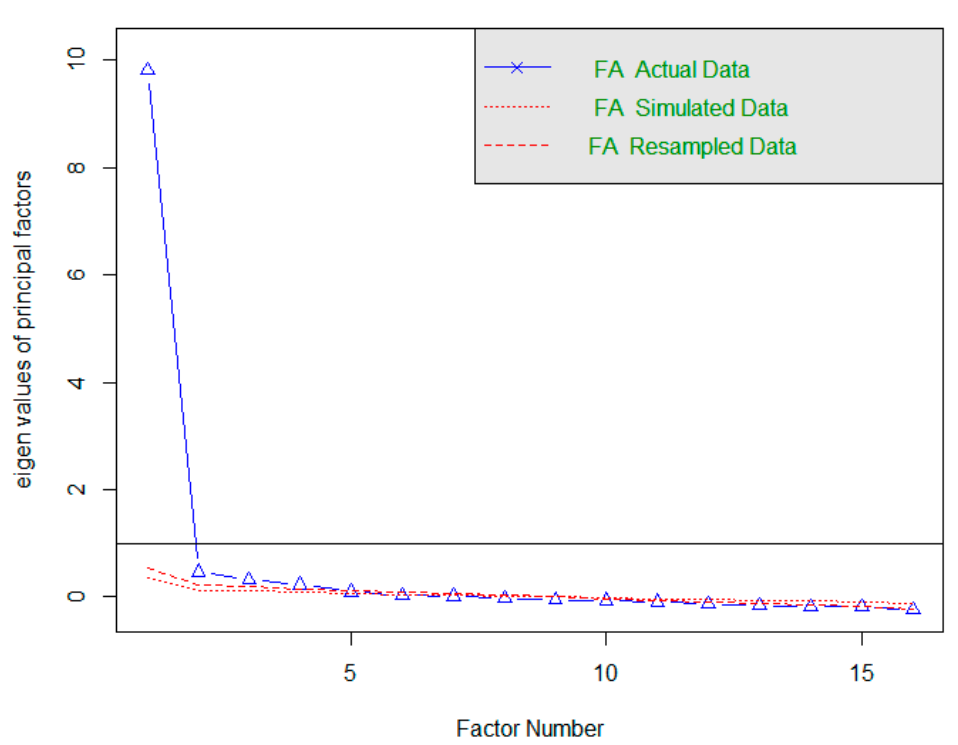
Figure A1. The Scree plot for a composite measure of Patient Health Questionnaire Anxiety and Depression Scale (PHQ-ADS).